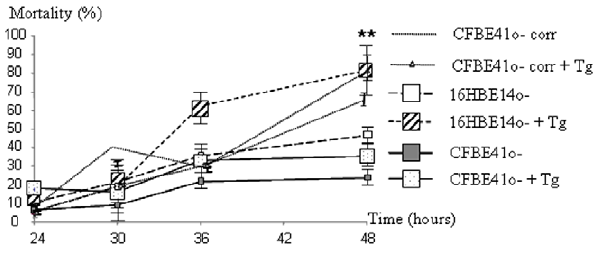
Figure 5. Percentage of mortality in 16HBE14o- and CFBE41o- cells in the presence of Tg. The curves represent the mortality time course under Tg treatment. In both cell types it was increased with time. Nevertheless, the mortality was higher in 16HBE14o- and CFBE41o- corr cells after 36 hours of Tg treatment (p , 0.001). Bars represent SEM